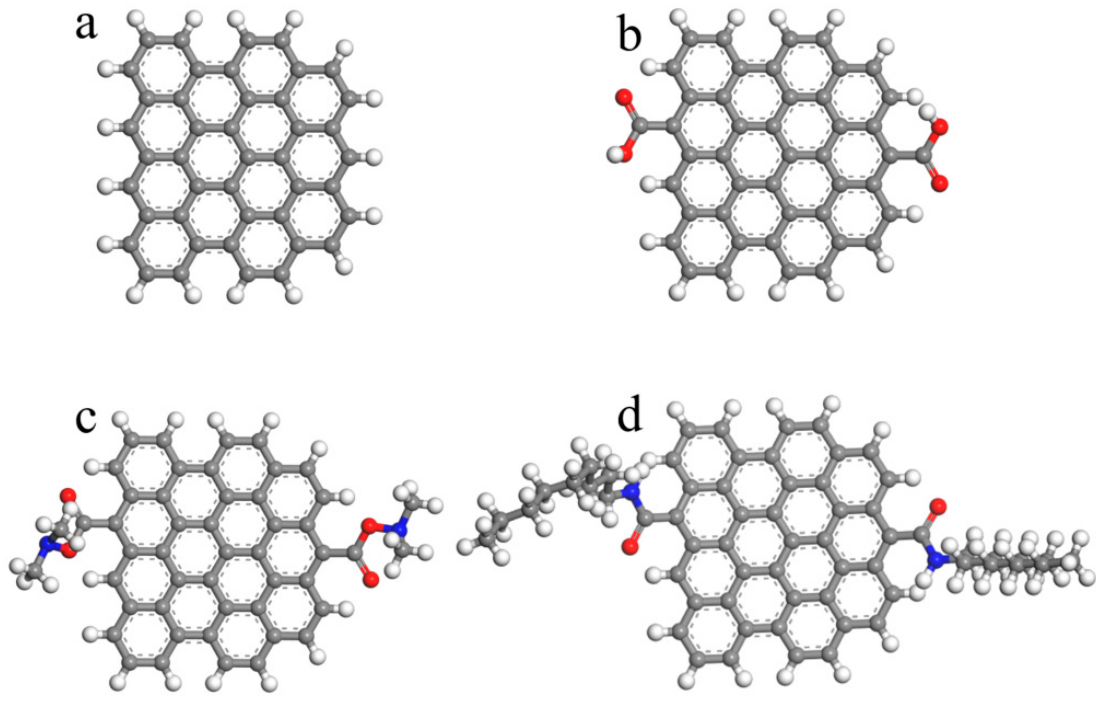
Figure 2. Graphene plates with various functional groups: ( a ) pure graphene ( b ) GO ( c ) MG and ( d ) AG.